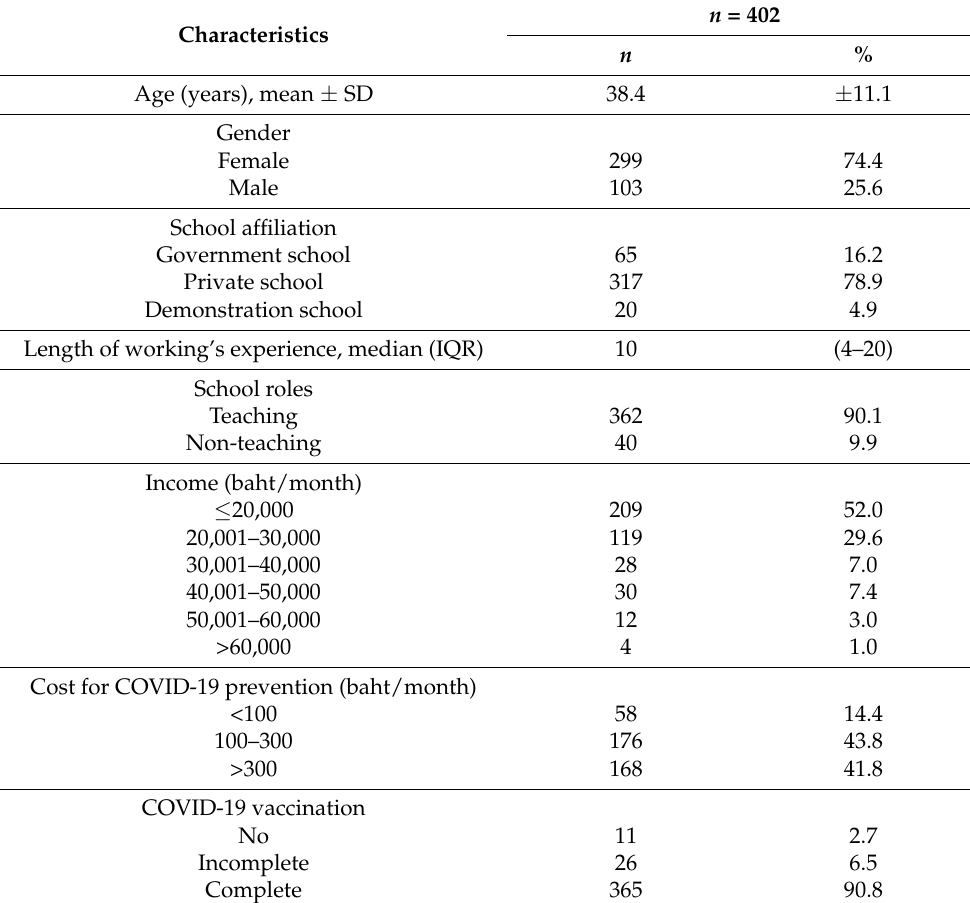
Table 1. The characteristics of the